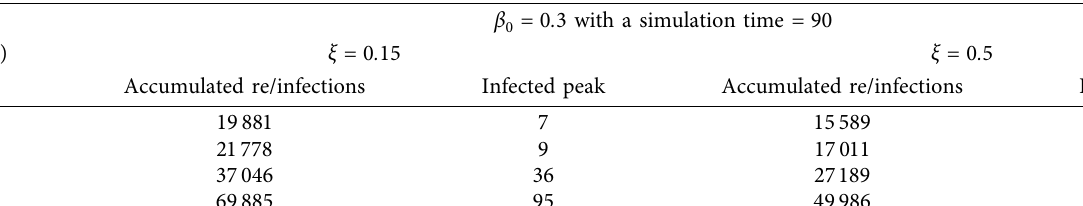
� 0 . 3, Λ � 10, and p � 0 . 1. 0